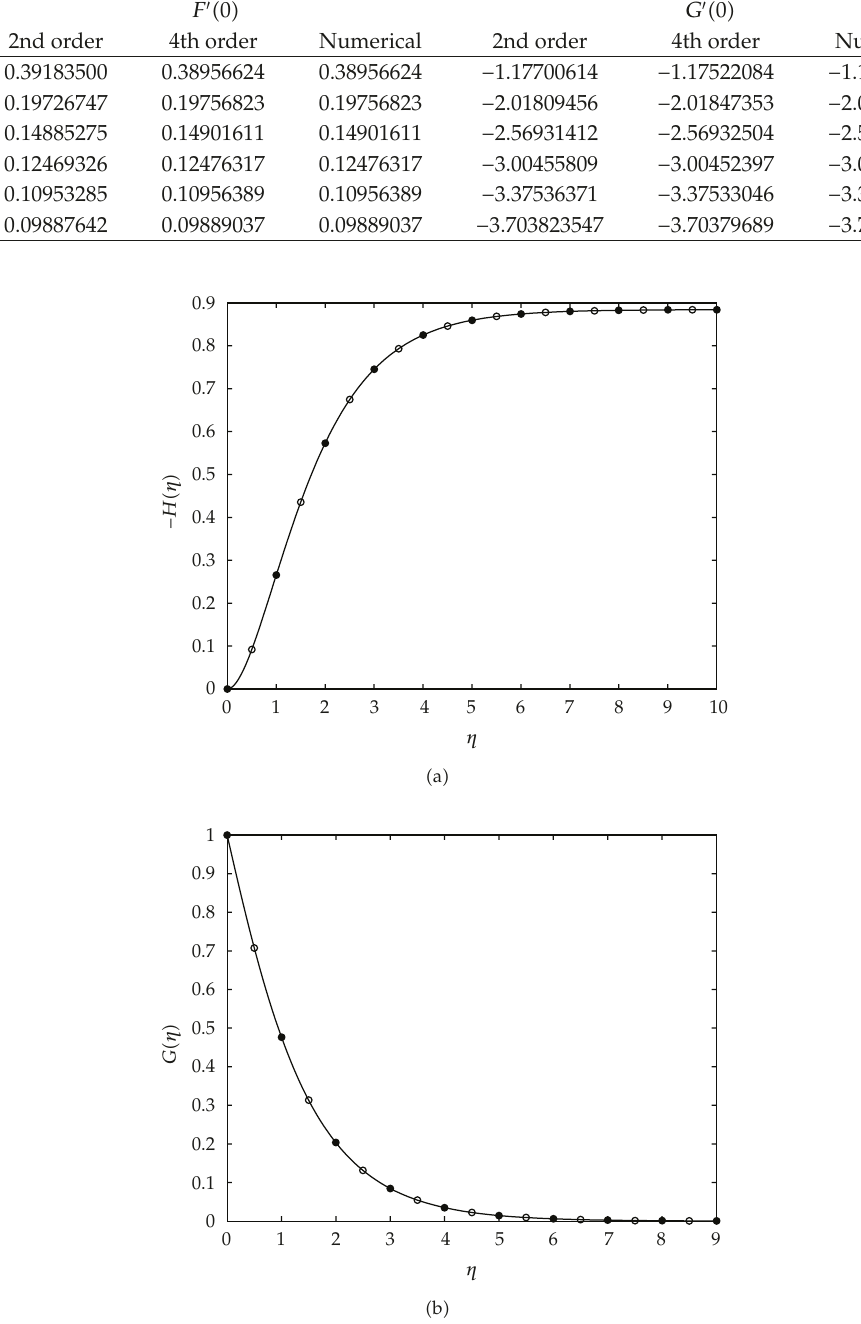
Figure 1: Comparison between the SHAM, SLM, and numerical solution of − H (cid:6) η (cid:7) and G (cid:6) η (cid:7) when (cid:2) (cid:10) − 1, L (cid:10) 20, and N (cid:10) 60. The open circles represent the SHAM 4th-order solution, the filled circles represent the 2nd-order SLM solution, and the solid line represent the numerical